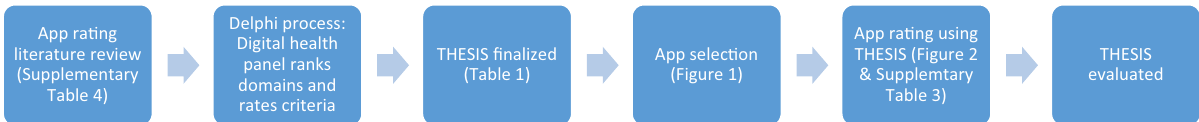
App ra(cid:2)ng literature review App selec(cid:2)on Fig. 3 Path to building and evaluating THESIS. The methods taken in the development and evaluation of THESIS. Apps from systematic keyword search in Apple and Google stores ( n =